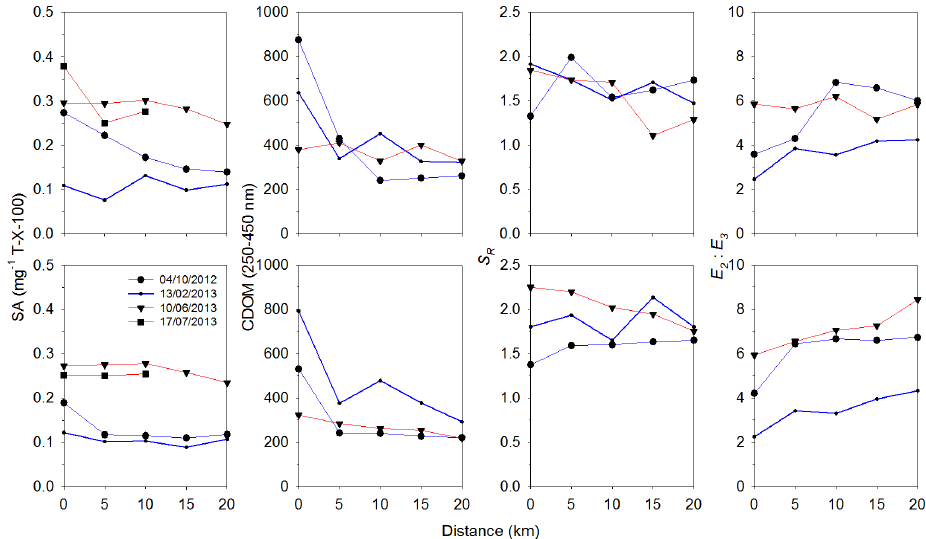
Figure 2. Surfactant activity (normalised to Triton T-X-100), CDOM (Total a 250 to 450nm), S R and E 2 : E 3 ratio of the sea surface microlayer (SML; top panels) and sub-surface water (SSW; bottom panels) from North Sea transects during